Question: What type of chart is this?
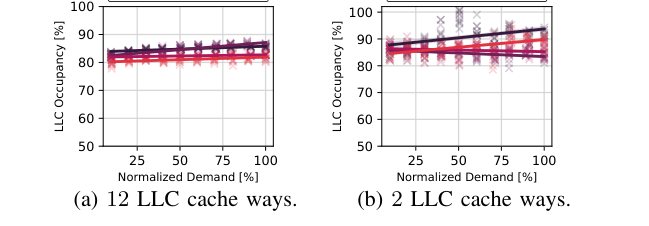
Answer: line